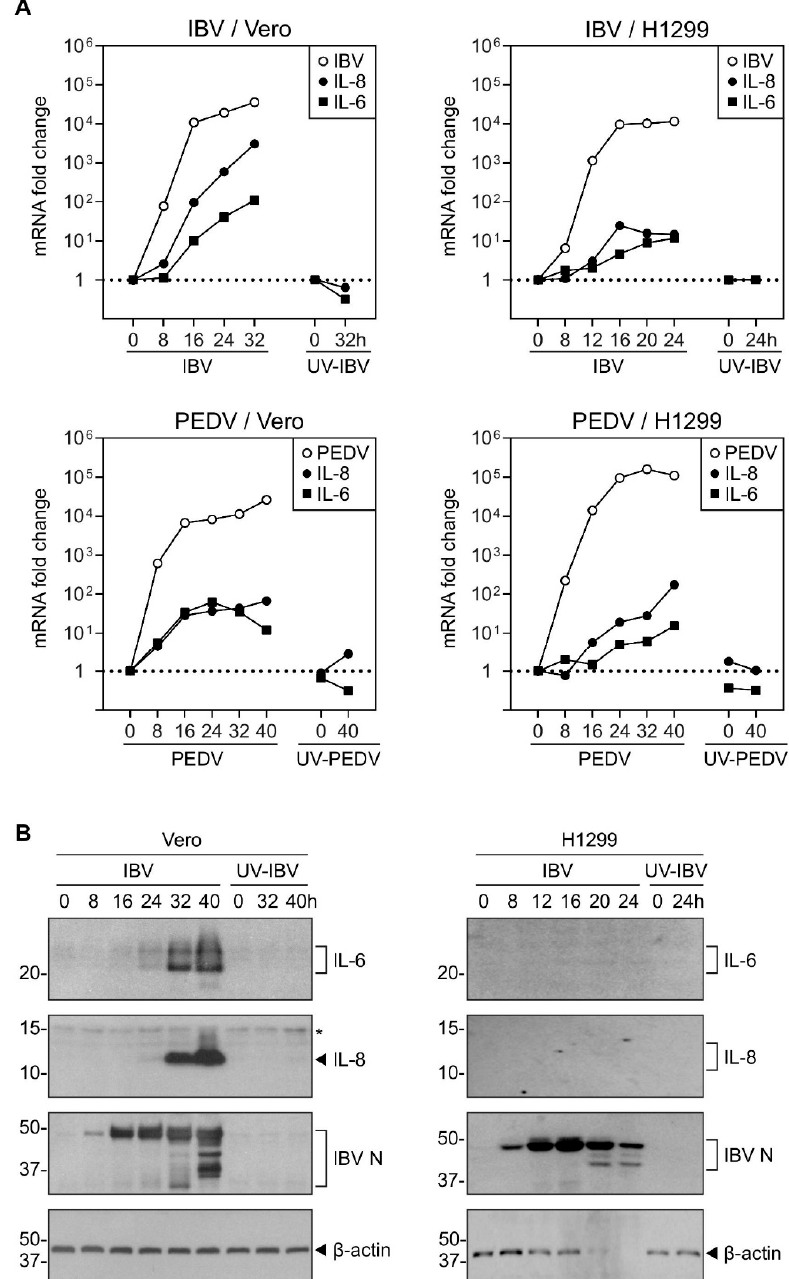
Figure 1. Upregulation of IL-8 mRNAs and proteins during IBV and PEDV infection. ( A ) H1299 and Vero cells were infected with IBV and PEDV at MOI~2 or mock-treated with UV-inactivated viruses. Cell were harvested at the indicated time points and total RNA samples were extracted for RT-qPCR. The levels of IBV genomic RNA (IBV) and PEDV genomic RNA (PEDV), and the mRNA levels of IL-8 and IL-6 were determined by the ΔΔ Ct method using the GAPDH mRNA of the virus-infected 0 hpi sample for normalization. The experiment was repeated three times with similar results, and the result of one representative experiment is shown. ( B ) Vero and H1299 cells were infected with IBV at MOI~2 or mock-treated with UV-inactivated IBV. Cell lysates were harvested at the indicated time points and subjected to Western blot analysis using the indicated antibodies. Beta-actin was included as the loading control. Sizes of protein ladders, in kDa, are indicated on the left. The experiment was repeated three times with similar results, and the result of one representative experiment is shown. Asterisk (*) indicates the nonspecific band detected by the IL-8 antibody.